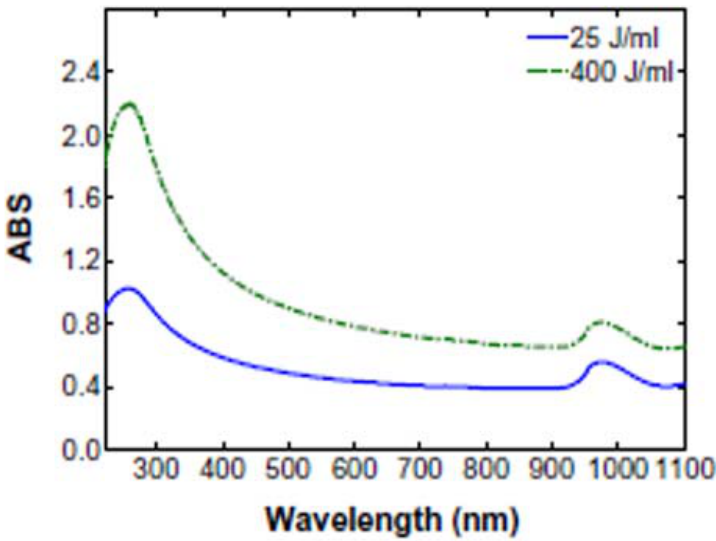
Figure 10. Typical UV–Vis spectrum of MWCNT with the two absorption bands at 253 nm and 970 nm [35].